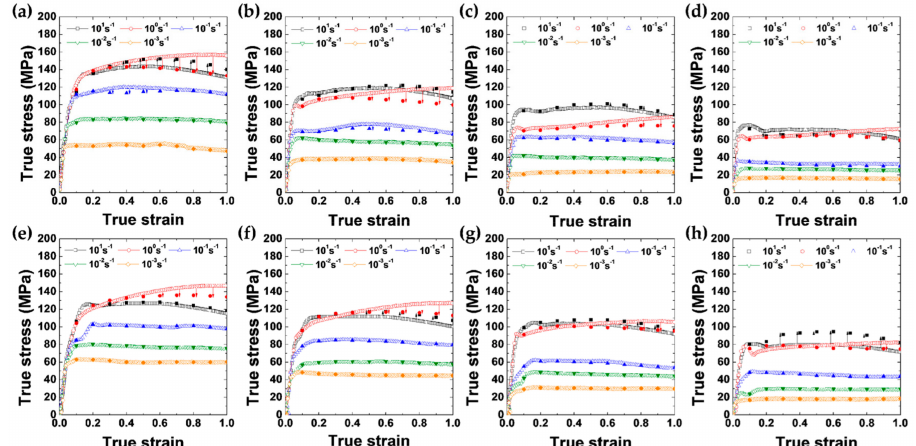
Figure 3. The true stress–true strain curves of the cast alloy at ( a ) 573 K, ( b ) 623 K, ( c ) 673 K and ( d ) 723 K. The true stress–true strain curves of the extruded alloy at ( e ) 573 K, ( f ) 623 K, ( g ) 673 K and ( h ) 723 K. The flow stresses corrected for adiabatic heating are indicated by solid symbols.